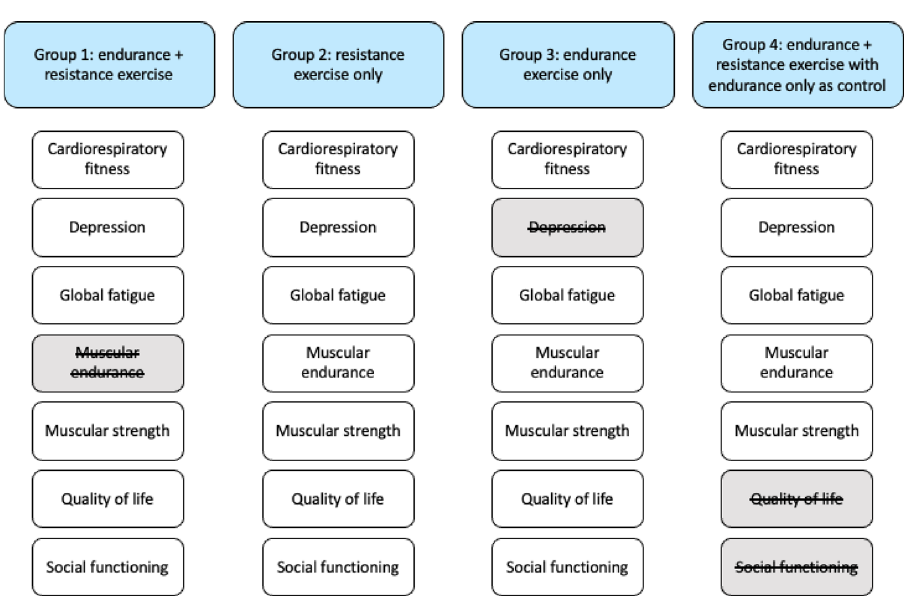
Figure 1. Graphical representation of how papers were sorted in data handling to use in their respective meta-analyses. Grey shading and score-through represent groupings for which there were not enough studies to analyse certain outcome